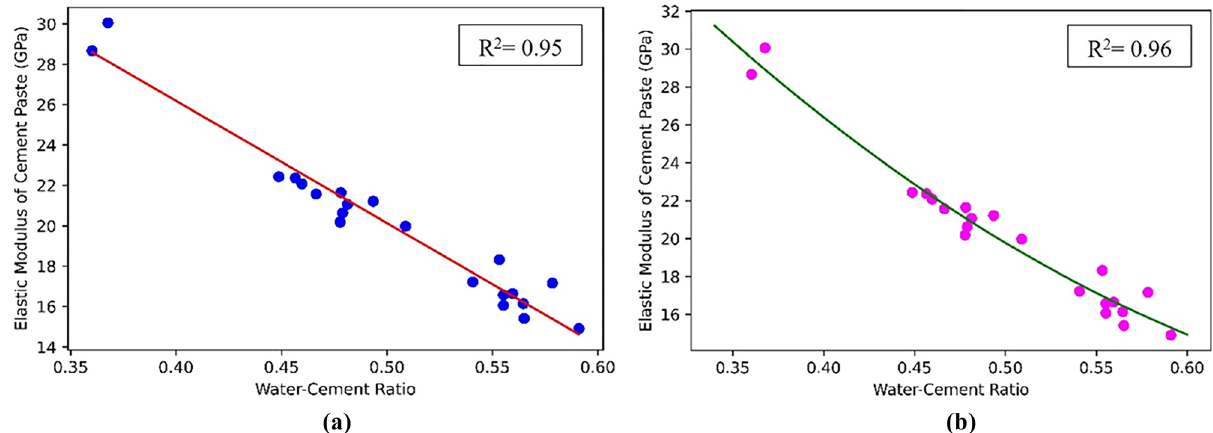
Figure 3. Prediction curves between w/c ratio and the elastic modulus of cement paste in ( a ) linear regression; ( b ) polynomial